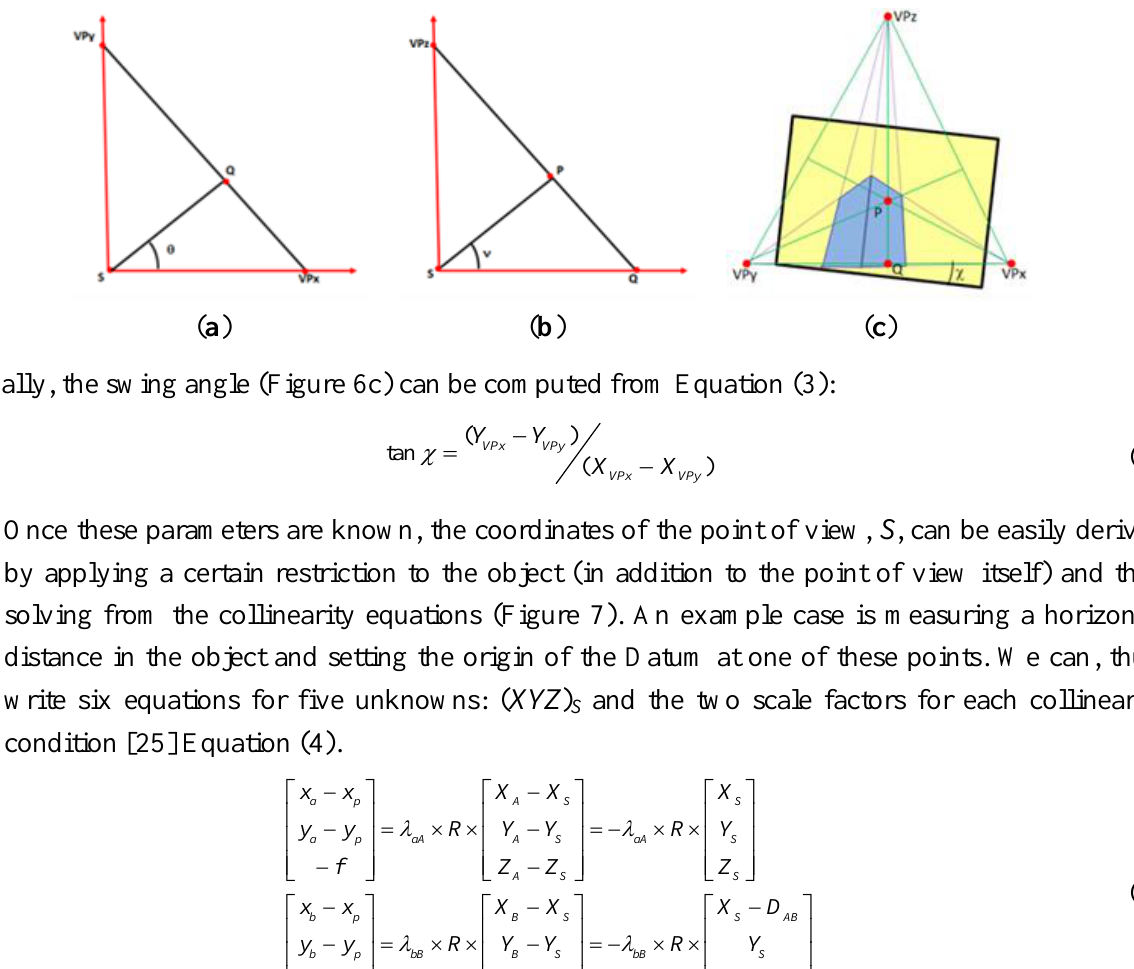
Figure 6. ( a ) Horizontal triangle formed by the point of view, S , and the horizontal vanishing points VPx and VPy ,with the azimuth angle ( θ ); ( b ) Vertical triangle formed by the point of view, S , the vertical vanishing point, VPz , and the intersection of the horizon and maximum slope lines, Q , with the tilt angle ( ν ); ( c ) Perspective triangle formed by the three vanishing points ( VPx , VPy , VPz ) that contains the principal point ( P ) as the intersection of the heights of the triangle and image showing the swing angle ( χ ) around the camera axis: the horizon line and the width image edges are not parallel (in addition, the maximum slope line and the height image edges are not